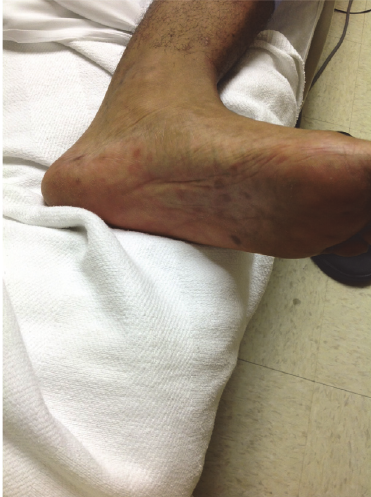
Figure 2: Photograph demonstrating a maculopapular rash dis- tributed on the sole of the feet bilaterally.